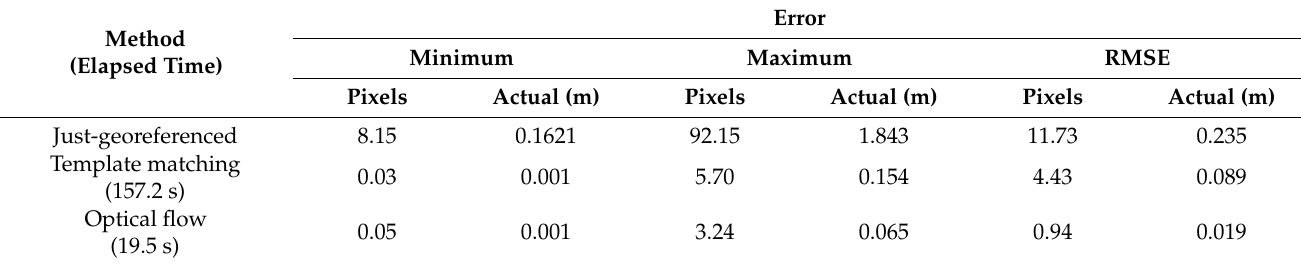
Table 1. Spatial accuracy comparison between just-georeferenced imagery, based on the RGB orthogonal image, image registration based on template matching, and the technique proposed in this